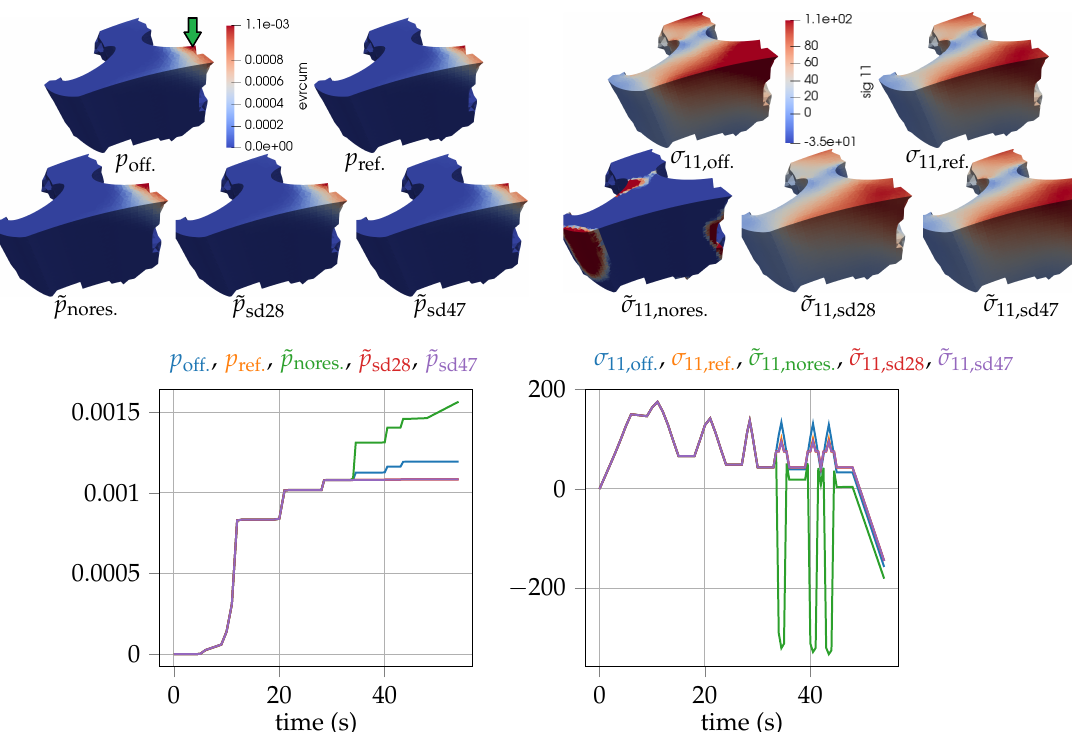
Figure 13. ( top ) Diverse HF and ROM dual quantity fields at t = 43.5 s for subdomain 47, ( left ) p , ( right ) σ 11 ; ( bottom ) comparison at the point identified by the green arrow on the top-left picture. The components of the stress tensor are in